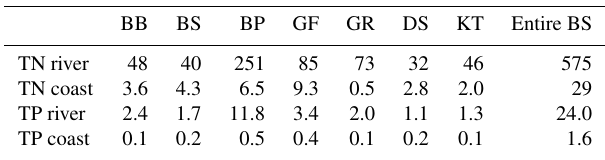
Table 10. Average (2013–2017) riverine and coastal nutrient inputs (10 3 tN(P)yr − 1 ) to the major basins of the Baltic Sea. For abbre- viated basin names, see Fig. 11. TN and TP are total nitrogen and total phosphorus inputs, respectively. Data source: updated